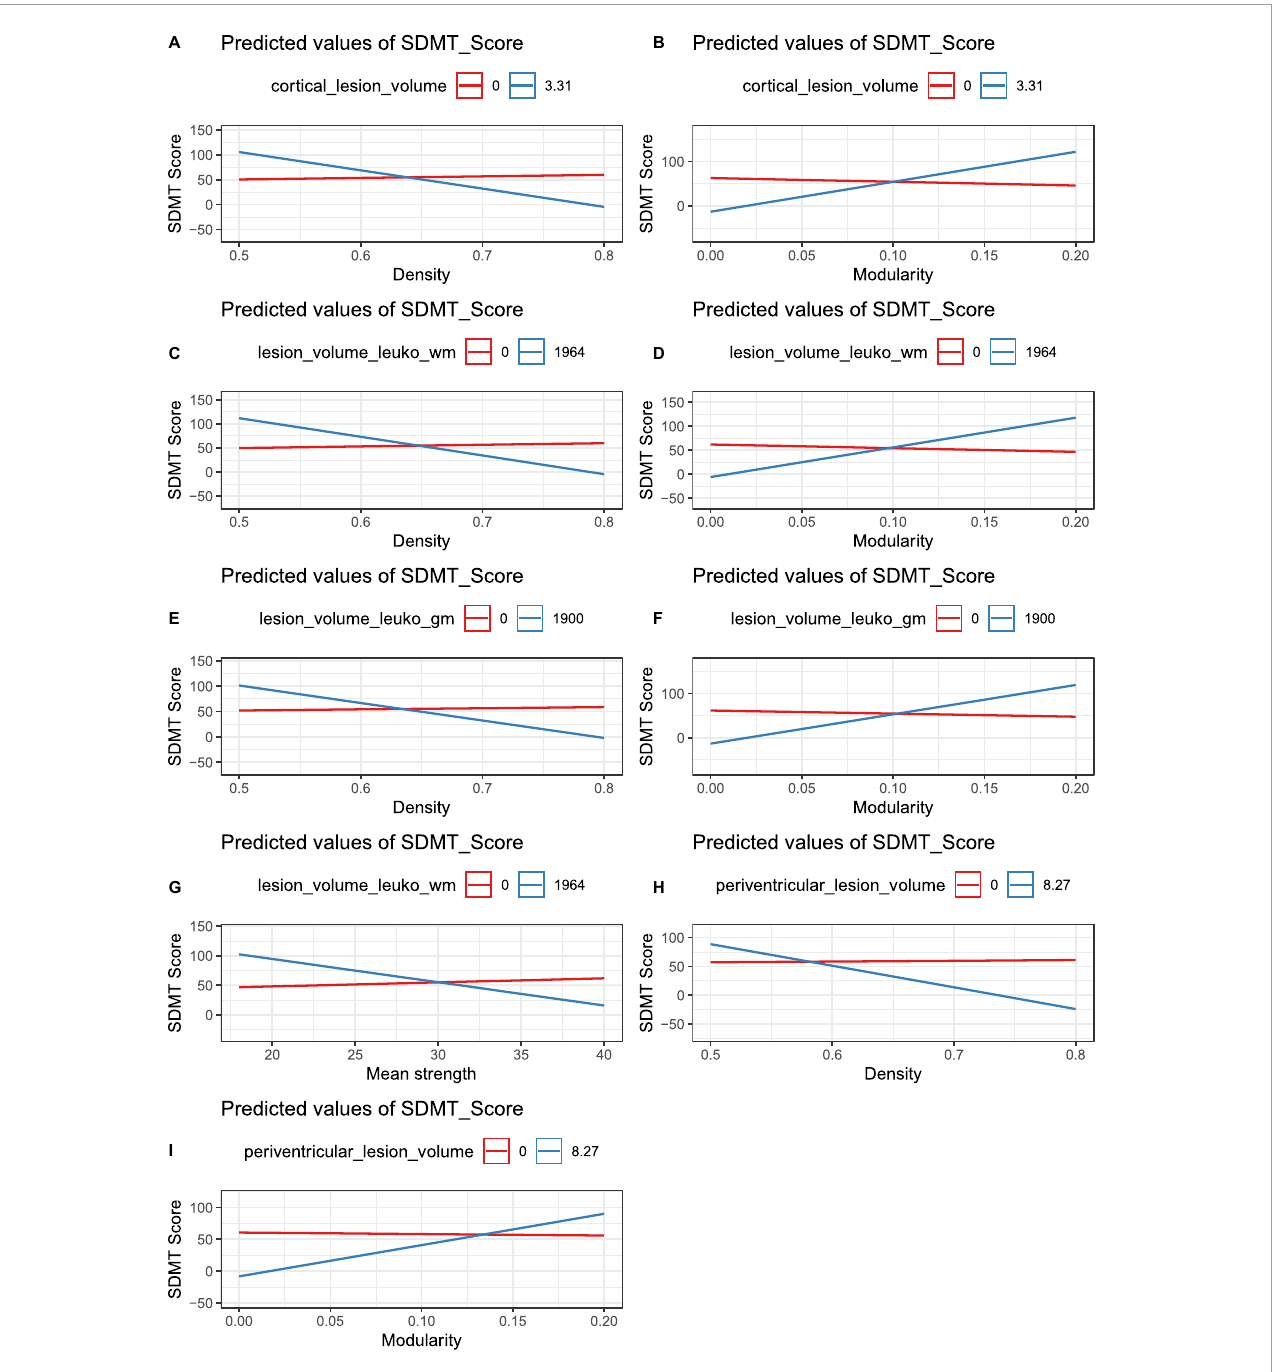
FIGURE4 Interaction plots between symbol digit modalities test (SDMT), different lesion types, and global graph metrics in patients with multiple sclerosis (pwMS). Only significant interactions are shown. The red line shows the relationship between SDMT and network properties if no lesions are present while the blue line describes the interaction effect between high lesion volume, global graph metric, and SDMT. (A) Interaction between cortical lesion volume, density, and SDMT in pwMS. (B) Interaction between cortical lesion volume, modularity, and SDMT in pwMS. (C) Interaction between leukocortical white matter lesion volume, density, and SDMT in pwMS. (D) Interaction between leukocortical white matter lesion volume, modularity, and SDMT in pwMS. (E) Interaction between leukocortical gray matter lesion volume, density, and SDMT in pwMS. (F) Interaction between leukocortical gray matter lesion volume, modularity, and SDMT in pwMS. (G) Interaction between leukocortical white matter lesion volume, mean strength, and SDMT in pwMS. (H) Interaction between periventricular lesion volume, density, and SDMT in pwMS. (I) Interaction between periventricular lesion volume, modularity, and SDMT in